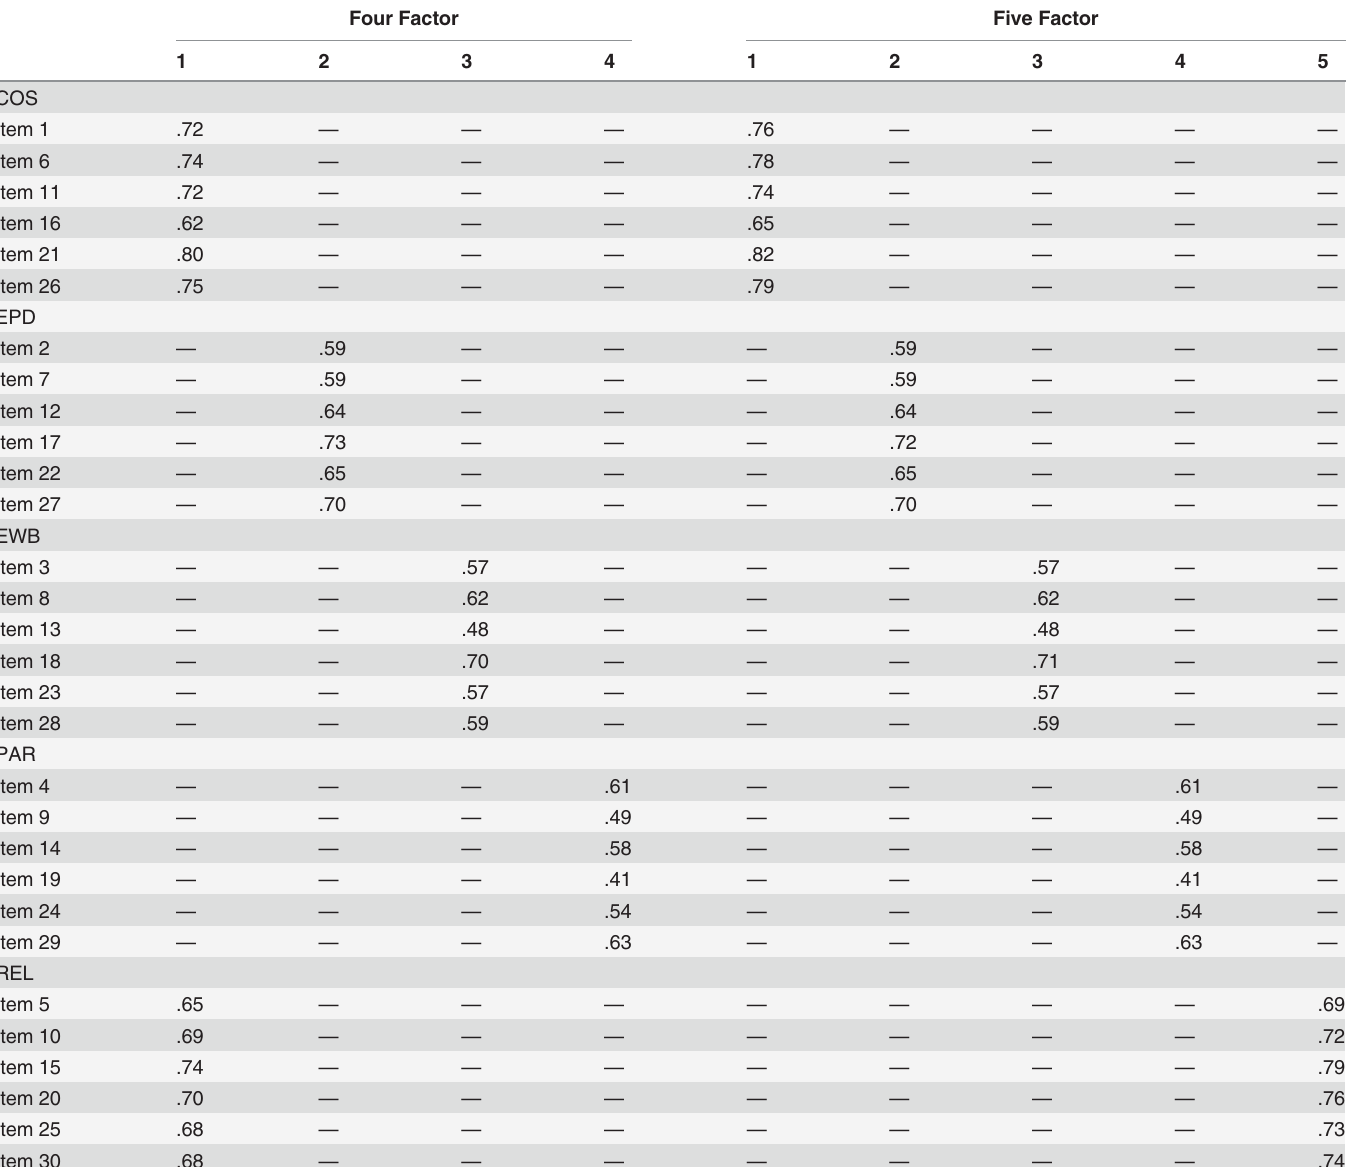
Table 10. Standardized Regression Weights and Goodness-of-Fit Statistics for Both Four and Five Factor Models of the ESI-R Using the Total Combined Sample (N = 4004). Four Factor Five Factor 1 COS